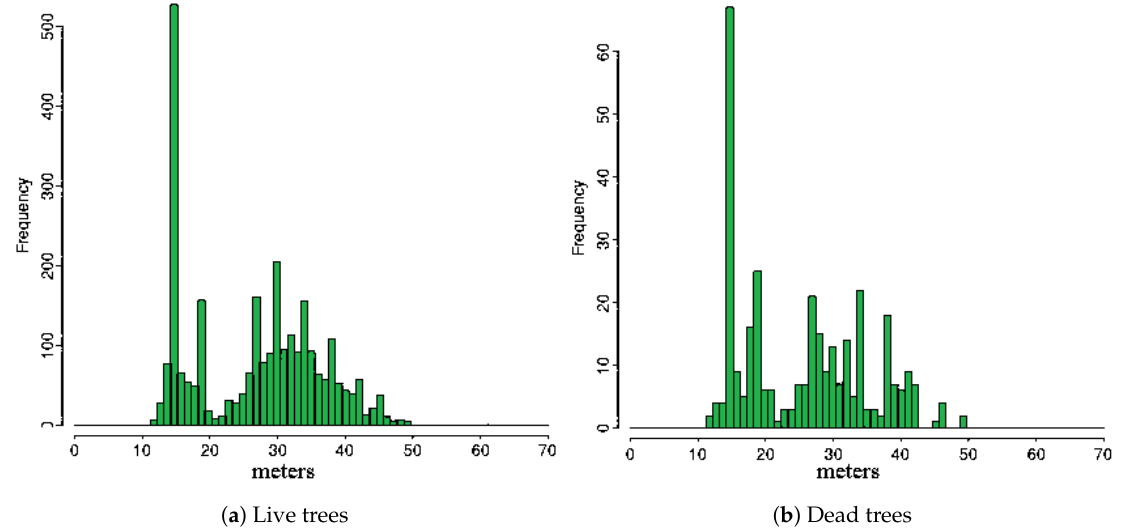
Figure 5. Histograms of elevation at tree locations listed within the field data using a single column to measure the elevation. Histogram ( a ) includes the heights of the Live Trees and histogram ( b ) the heights of the dead